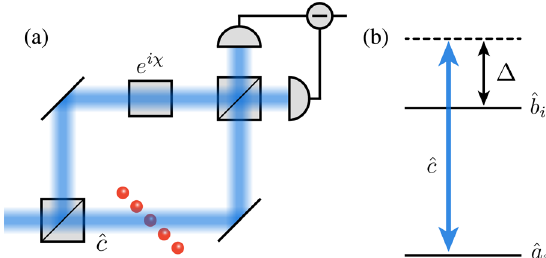
FIG. 4. (a) Schematic setup for the interferometric measure- ment of the EGP. Photons are injected into one input, and the intensity difference between the two outputs is detected. In the lower arm of the interferometer, each photon interacts with the 1D chain of fermions corresponding to the probed system. (b) Internal fermionic level scheme. On each site i , the photonic mode ˆ c couples ground and excited levels (with annihilation operators ˆ a ˆ b and , respectively) in an off-resonant way (large detuning Δ i